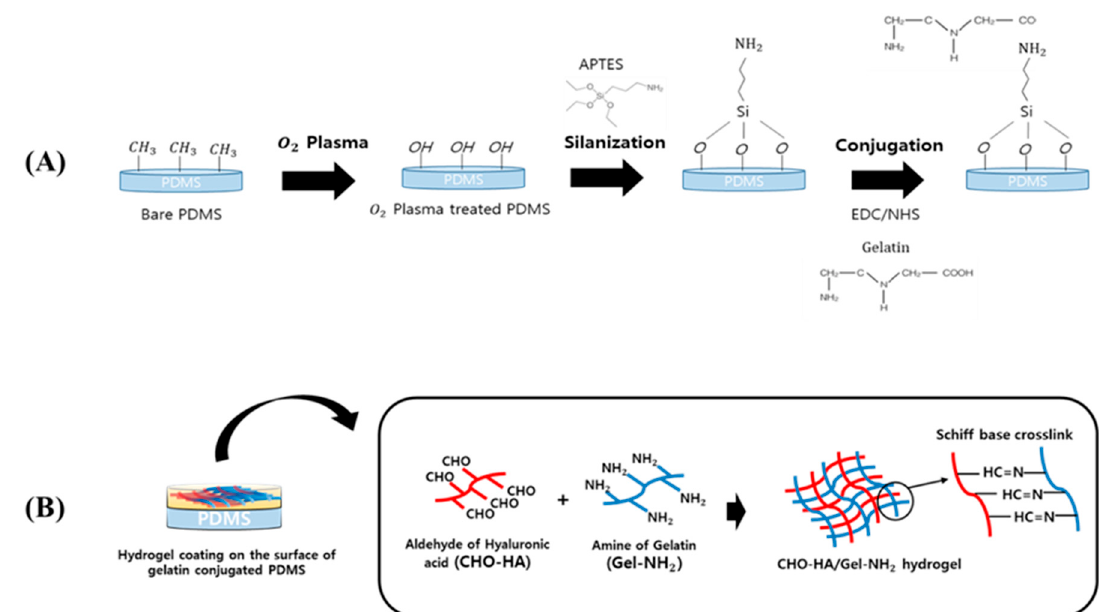
Scheme 1. Illustration of the poly(dimethylsiloxane) (PDMS) surface treatment: ( A ) Gelatin conjugation with PDMS using (3-aminopropyl)triethoxysilane (APTES); ( B ) Hydrogel coating on the surface of gelatin-conjugated PDMS using 1-ethyl-3-(3-dimethylaminopropyl)carbodiimide (EDC)/N-hydroxysuccinimide (NHS) reaction.